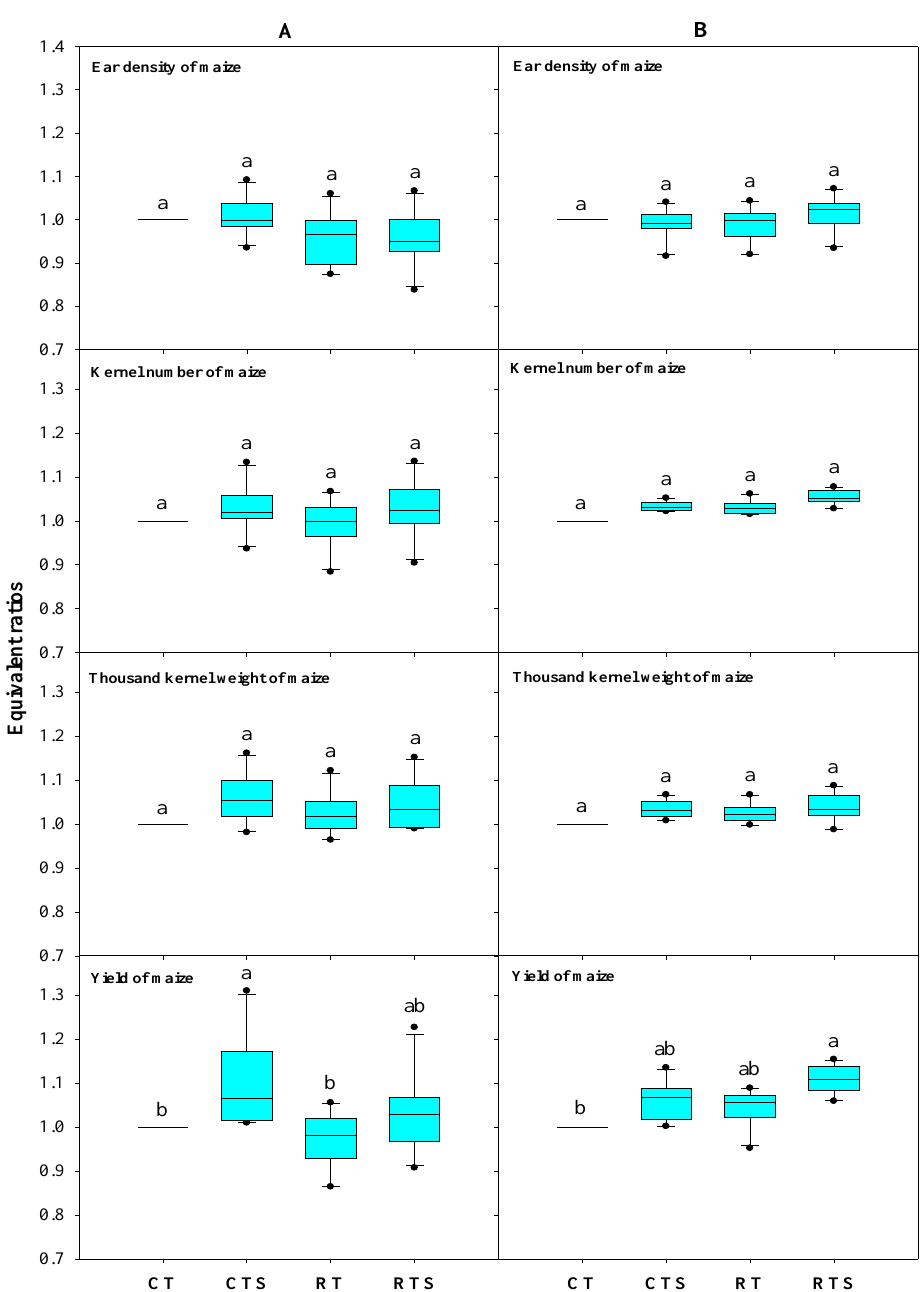
Figure 6. Box plots of equivalent ratios of the maize yield and yield components under tillage and straw returning practices at the Tai’an ( A ) and Longkou ( B ) experimental sites. The horizontal line inside the boxes denotes the median value. The error bars show the upper/lower quartiles (1.5 interquartile distance). The line extending vertically from the box represents the variability beyond the range of the upper and lower quartiles, and the values represent the 10th and 90th percentiles, respectively; the points that lie outside of this range are shown as solid circles. CT: conventional tillage without straw returning; CTS: conventional tillage with straw returning; RT: rotary tillage without straw returning; RTS: rotary tillage with straw returning. Different letters in each group indicate significant differences between different treatments ( p < 0.05 ; Duncan’s test).